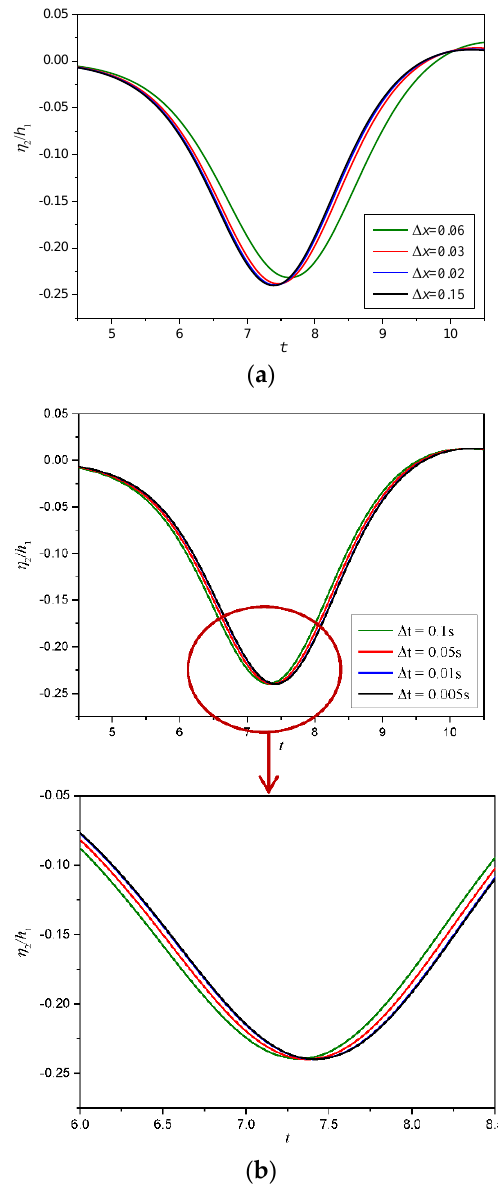
Figure 4. Convergence verification of profile in regard to mesh sizes ( a ) and time step ( b ). In order to further verify the accuracy of the numerical model, the fluid velocity in the inner region was calculated using the present method. The velocity potential in the inner region can be expressed as integral Equation